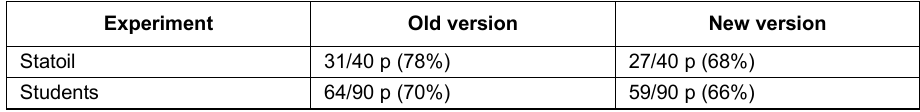
Table 6. OM05.07.01.03